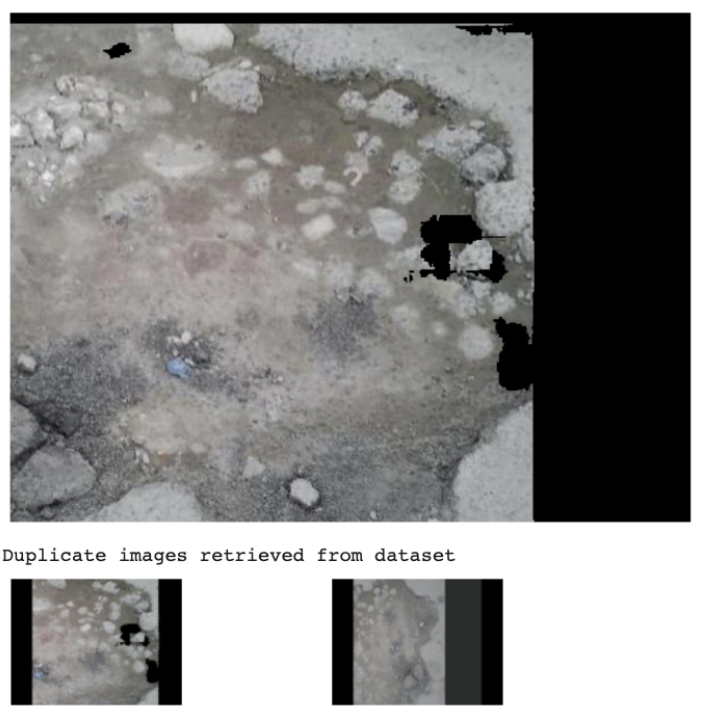
Figure 5. Sample of duplicate images found by combining the Scale-Invariant Feature Transform (SIFT) and Fast Library for Approximate Nearest Neighbors (FLANN)